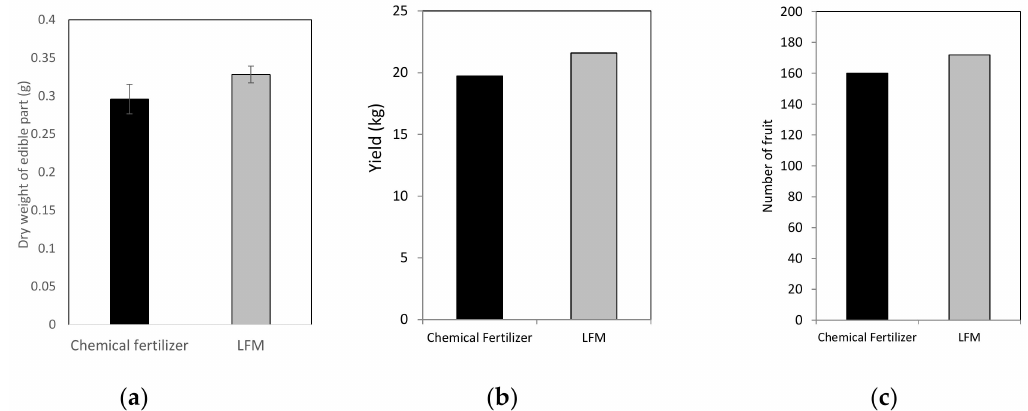
Figure 4. Field experiment testing the e ff ect of liquid food waste materials (LFM) on the growth of Lettuce ( a ) and eggplant ( b , c